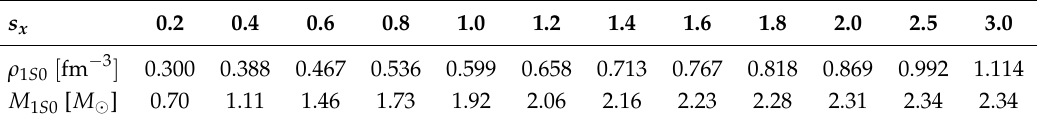
Table 1. NS matter baryon densities ρ 1 S 0 for the vanishing of the p1S0 gap and corresponding NS masses M 1 S 0 with that central density, as a function of the scale parameter s x .